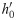
Illustration of switch
errors and block
breakpoints.In haplotype block2, there are two switch errors, where 1st to 5th bases, 8th to 12th bases are from h0′ but 6th to 7th bases come from h1′ on inferred haplotype h0.